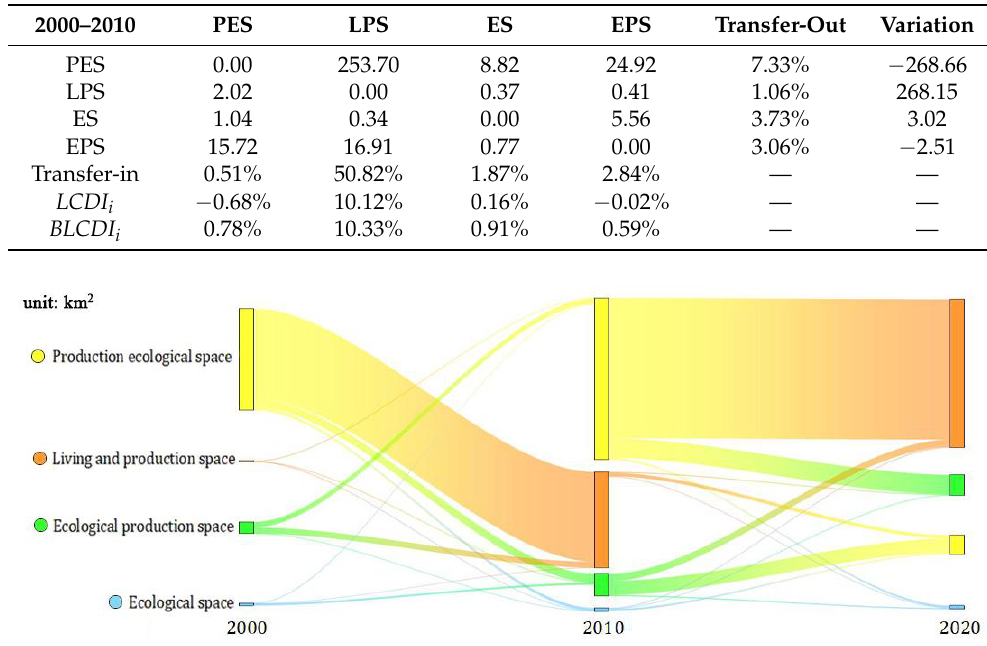
Table 3. Spatial transfer matrix of the PLES in the study area from 2000 to 2010 (unit: km 2 ).